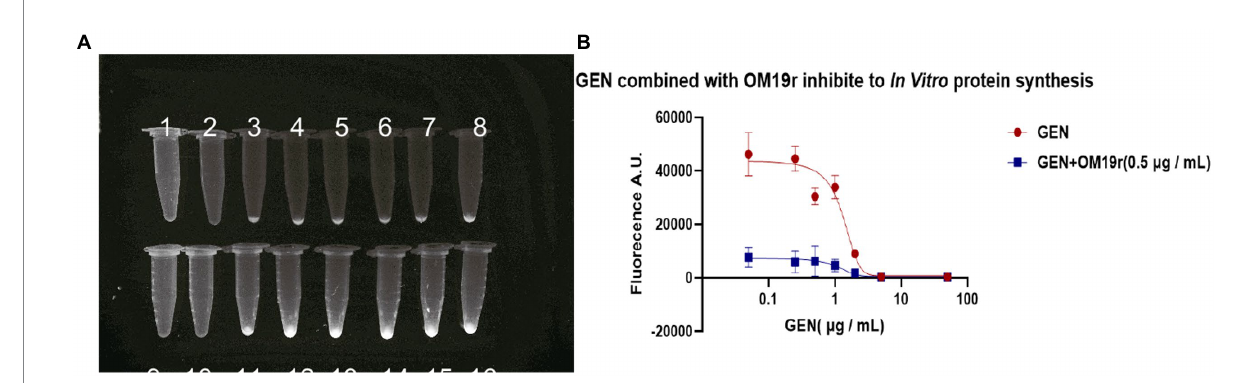
FIGURE 10 The effect of OM19r combined with GEN on in vitro protein synthesis. (A) EGFP green fluorescence observed under UV light by different concentrations of GEN and OM19r(0.5 μ g/ml) combined with GEN for 16 h. 1: OM19r combined with GEN (50 μ g/ml), 2: OM19r combined with GEN (5 μ g/ml), 3: OM19r combined with GEN (2 μ g/ml), 4: OM19r combined with GEN (1 μ g/ml), 5: OM19r combined with GEN (0.5 μ g/ml), 6: OM19r combined with GEN (0.25 μ g/ml), 7: OM19r combined with GEN(0.05 μ g/ml), 8: OM19r (0.5 μ g/ml), 9: GEN (50 μ g/ml), 10: GEN (5 μ g/ml), 11: GEN (2 μ g/